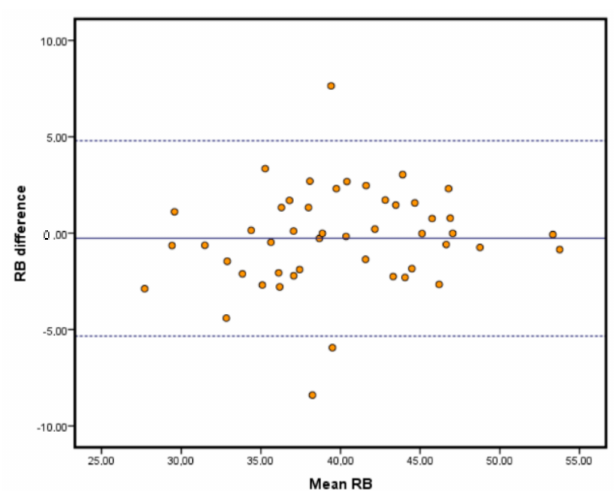
Figure A2. Bland-Altman plot extension.